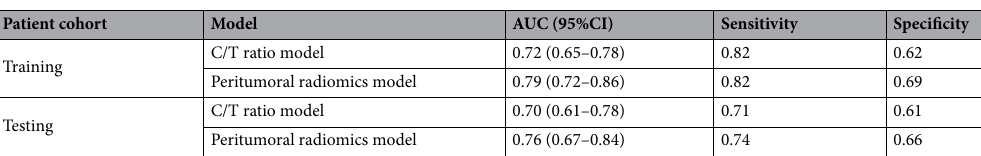
Table 2. Predictive performance of consolidation/tumor model and peritumoral radiomics model. C/T ratio consolidation/tumor ratio, AUC area under the curve, CI confidence